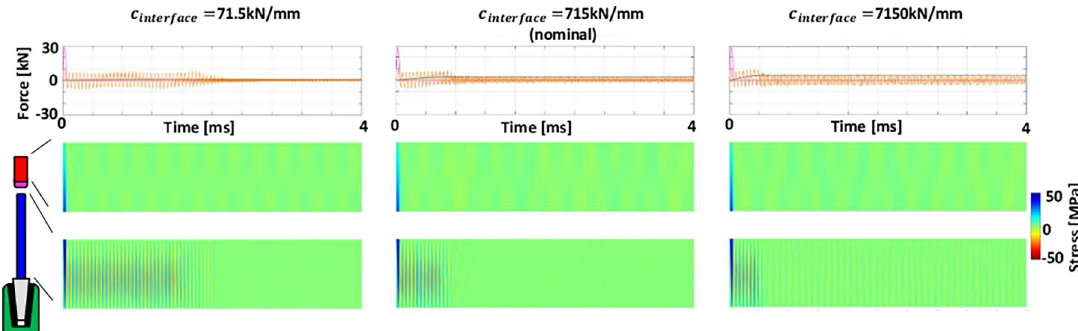
Fig 9. Note: Same colour-coding as Fig 3. Increasing the implant seating resistance of the implant into the bone has no effect on the impaction force (magenta) or the magnitude of the force between introducer and implant (orange). However, implant seating force (black) increases and is more rapid, with fewer stress oscillations in the introducer (contour